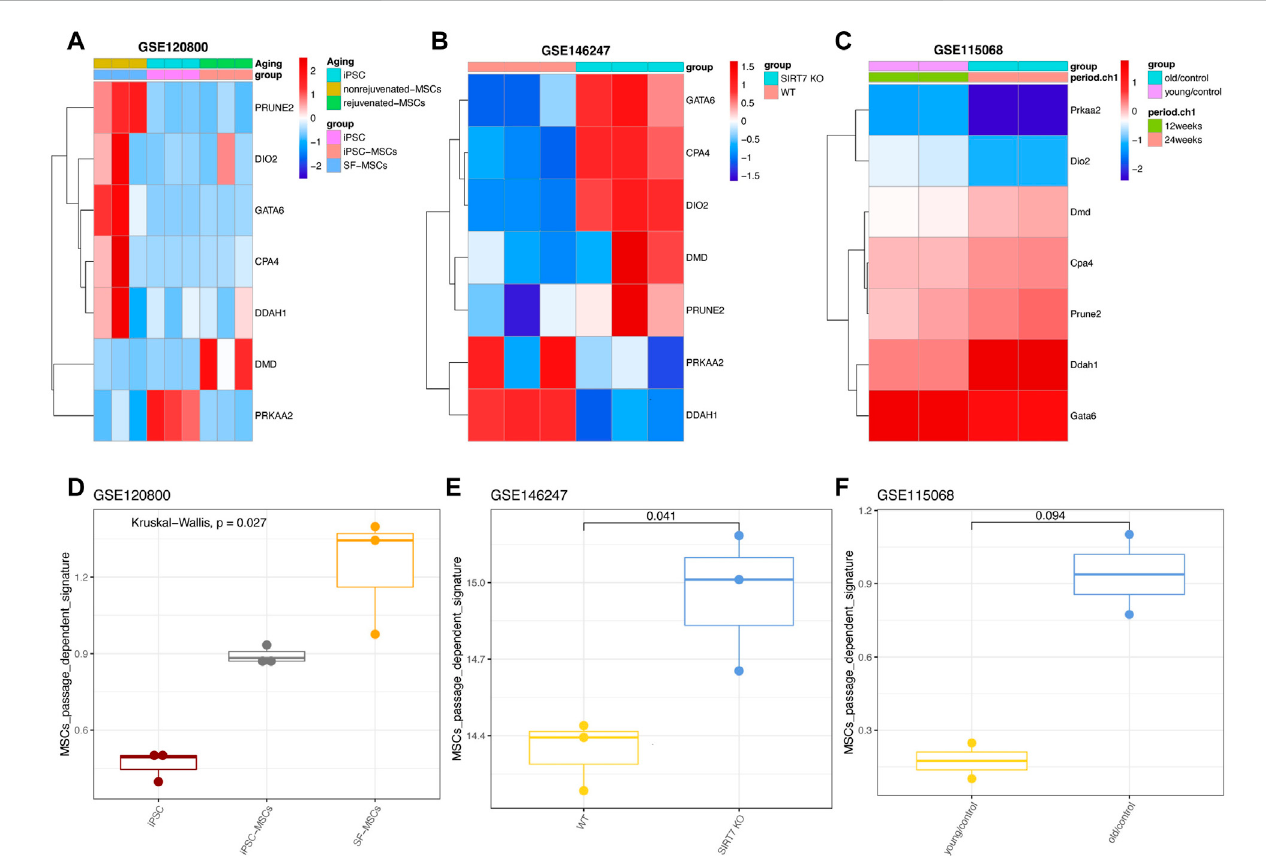
FIGURE 7 Expression patterns of seven genes in manipulated MSCs. (A) Expression pattern of seven genes in GSE120800 (B) Expression pattern of seven genes in GSE146247. (C) Expression pattern of seven genes in GSE115068. (D) Signature score of seven genes in GSE120800. (E) Signature score of hub genes in GSE146247. (F) Signature score of seven genes in GSE115068 with statistical